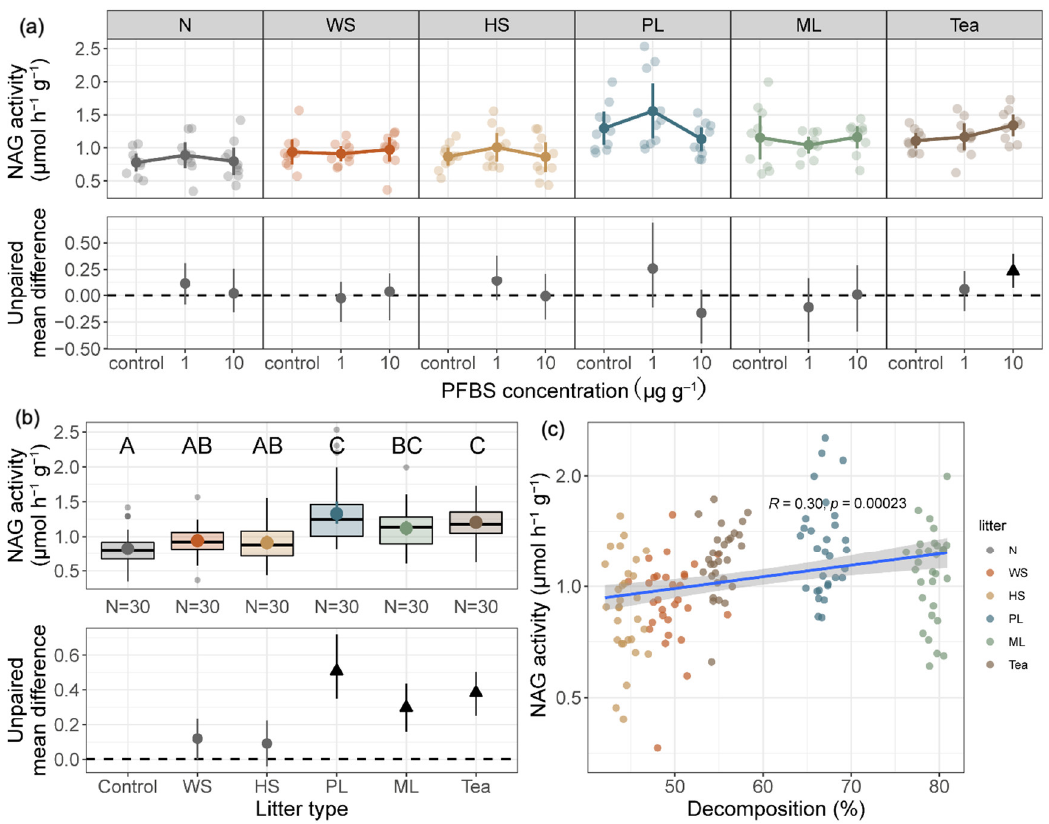
Figure 5. ( a ) Response of β-1,4-N-acetyl-glucosaminidase (NAG) activity to PFBS treatments within litter type; ( b ) Response of NAG activity to litter type regardless of PFBS concentrations; ( c ) Correlation of NAG activity with litter decomposition. The second row of the panel ( a ) showed the comparison of the unpaired mean difference between the treated and control group within a 95% confidence interval (CI). The grey spots indicated the neutral effects, while the black arrows pointing upwards represented positive effects. Different letters above the boxes in panel ( b ) indicated statistically significant differences among treatments at p < 0.05. N, no litter; WS, wheat straw; HS, hemp stem; PL, Plantago lanceolate ; ML, Medicago lupulina .